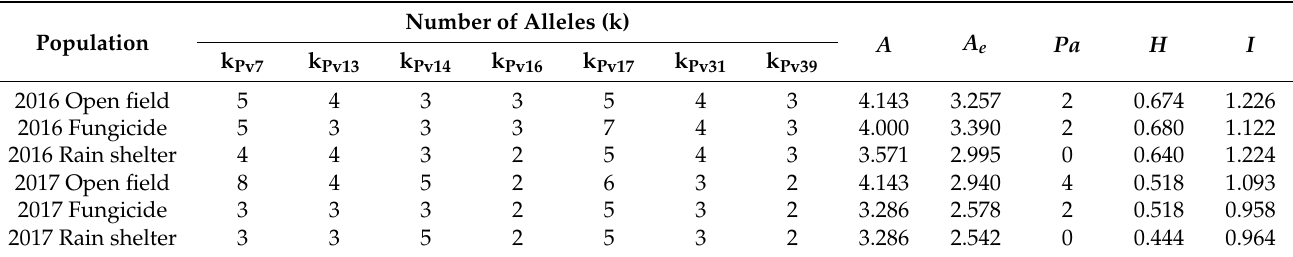
A , number of alleles; Ae , number of effective alleles; Pa , number of private alleles; H , Nei’s gene diversity; I , Shannon’s information index. Significant Fst values ( p < 0.05) were observed among the populations of the open- field, fungicide-managed, and rain shelter treatments in the same year. However, there was no significant differentiation in the populations between sampling years in the three types of management. The pairwise population Nm values based on the Fst values were calculated to measure the gene flow between populations. High Nm values ranged from 5.159 to 20.699 in 2016 and from 1.548 to 6.221 in 2017 based on pairwise comparisons of the populations under the open-field, fungicide-managed, and rain-shelter treatments, implying that there was frequent gene exchange among the different populations in the same growing season (Table 5). A comparative analysis indicated that the Das of the seven alleles was consistent among the populations of the three treatments in both years (Table 6). However, Pv7 and Pv17 differed by only 1–4 bp in the fungicide-managed plot in 2017. The predominant genotypes in 2017 were derived from the variation in predominant genotypes in 2016. An AMOVA was used to partition the total genetic diversity among and within the populations (Table 7). Table 5. Estimation pair-wise Fst (below diagonal) and gene flow values ( Nm = above diagonal) averaged over seven microsatellite loci of Plasmopara viticola populations in open-field, fungicide- managed, and rain-shelter cultivations during the period 2016–2017.